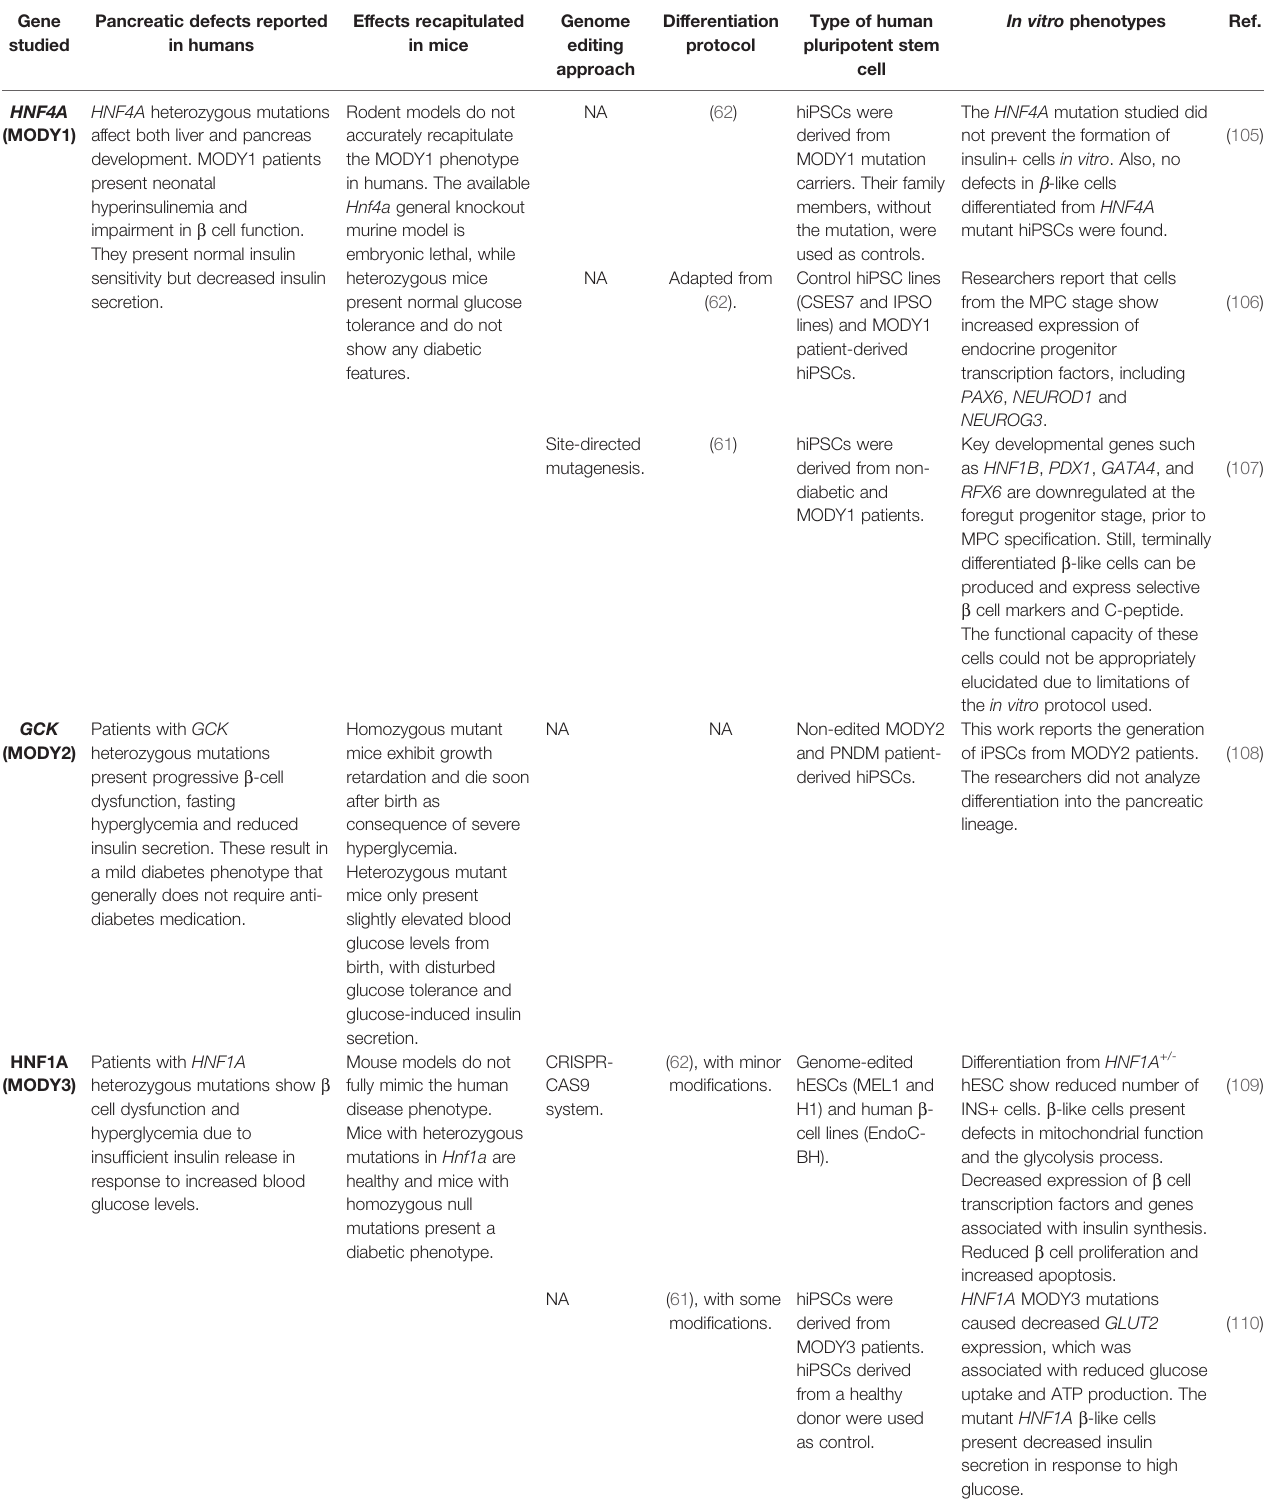
TABLE 1 | Summary of reports modeling maturity-onset diabetes of the young (MODY) mutation